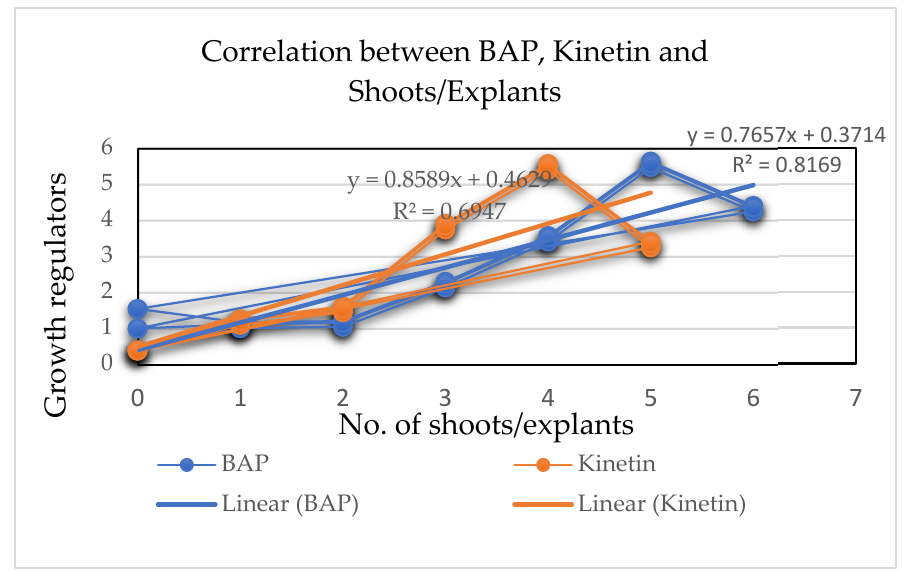
Figure 2. Correlation between BAP, kinetin, and shoots/explants.